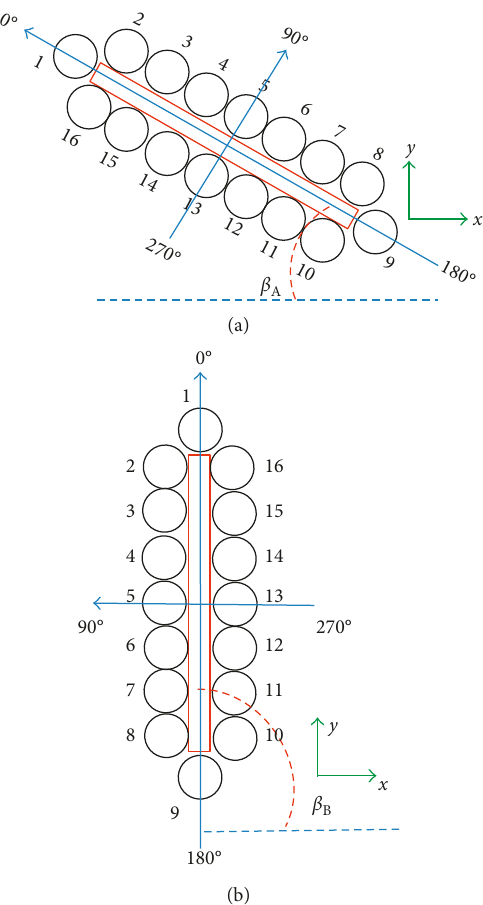
Figure 20: Schematic diagram of the measurement circle